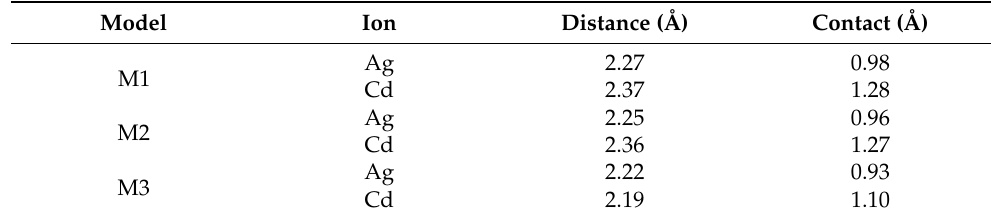
Figure 8. Common bonding configurations in nitrogen-doped carbon quantum dot surface. Repro- Table 3. Ion-nitrogen distance in the DFT interaction models.